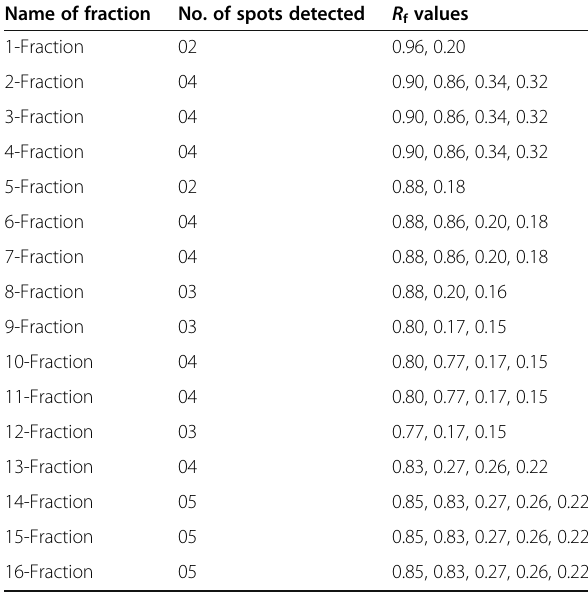
Table 3 R f values and number of spots detected of MeCV isolated